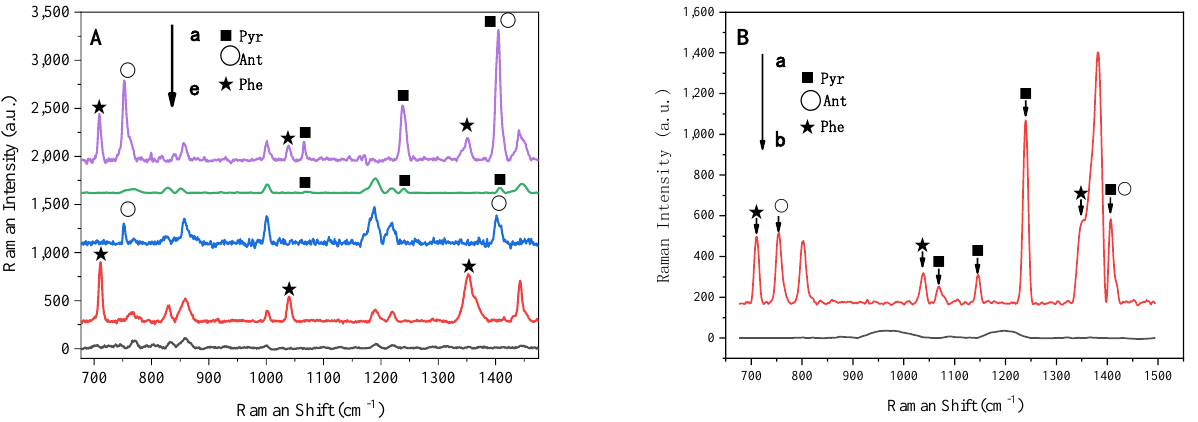
Figure 6. ( A ). ( a) SERS spectra of simulated water samples, (b) 1 μM pyrene– ethanol solution, (c) 10